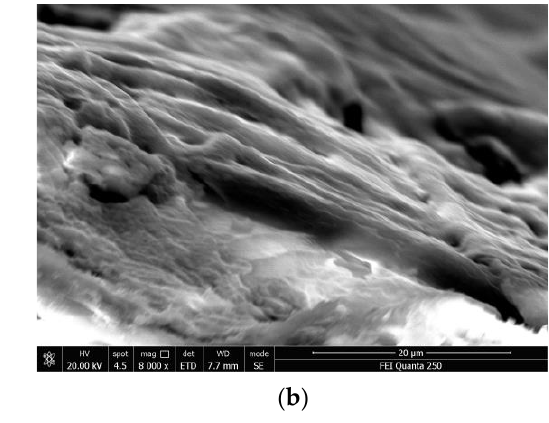
Figure 5. Film characterization: ( a ) Surface view; ( b ) Side view.